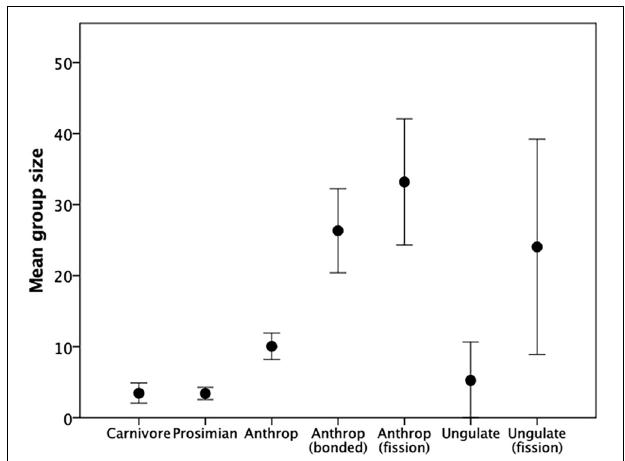
FIGURE 1 | Mean ( ± 95% CI) group size for different mammal taxa. Sources Pérez-Barbería et al. (2007); Shultz and Dunbar (2007). Source: Supplementary Dataset 1